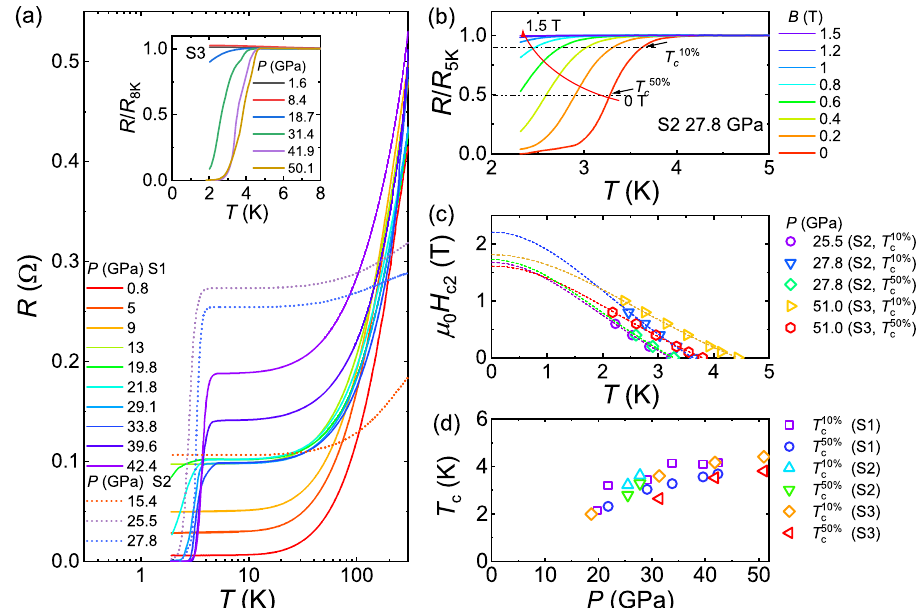
Fig. 6 Pressure-induced superconductivity in AuTe 2 Br. a Temperature dependence of the resistance of AuTe 2 Br single crystals with silicone oil as the pressure transmitting medium. S1, S2 and S3 represent different runs. b Magnetic fi eld dependence of the superconducting transition of AuTe 2 Br single crystal (S2) at 27.8 GPa. The superconducting transition temperatures T c are de fi ned as shown in the panel. c Temperature dependence of the upper critical fi eld μ 0 H c2 . Solid lines are a guide to the eye. d Pressure dependence of T c